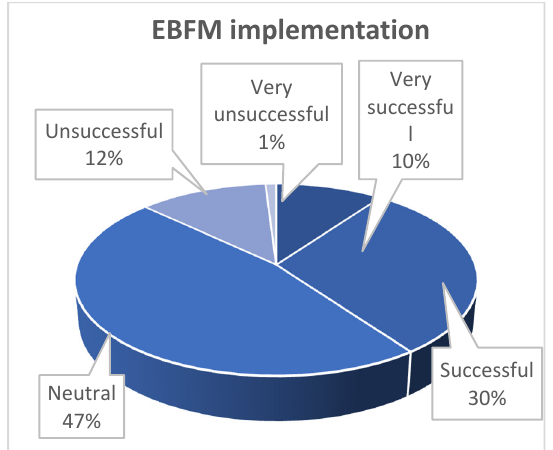
Figure 10. The perception of those respondents who said the EBFM process has been implemented regarding how successful the process had been (n = 107).